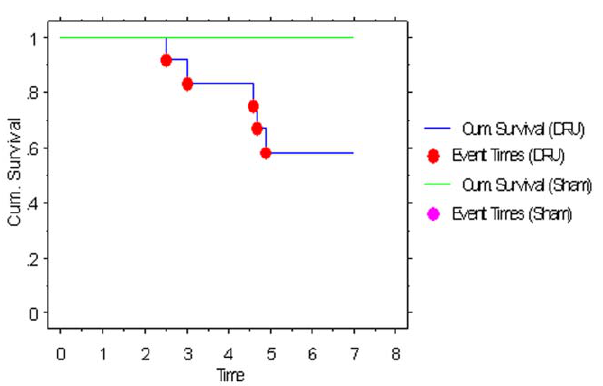
Figure 5. Survival analysis in animal model of dual liver transplantation . In sham group, all mice (n=12 ) survived more than 7 days. On 7 mice in dual right upper lobe transplantation survived more than 7 days with survival rate of 58.3%. DRU indicated the dual right upper lobes of liver.(long rank test could not get the p values because the in sham group contain no uncensored observation).